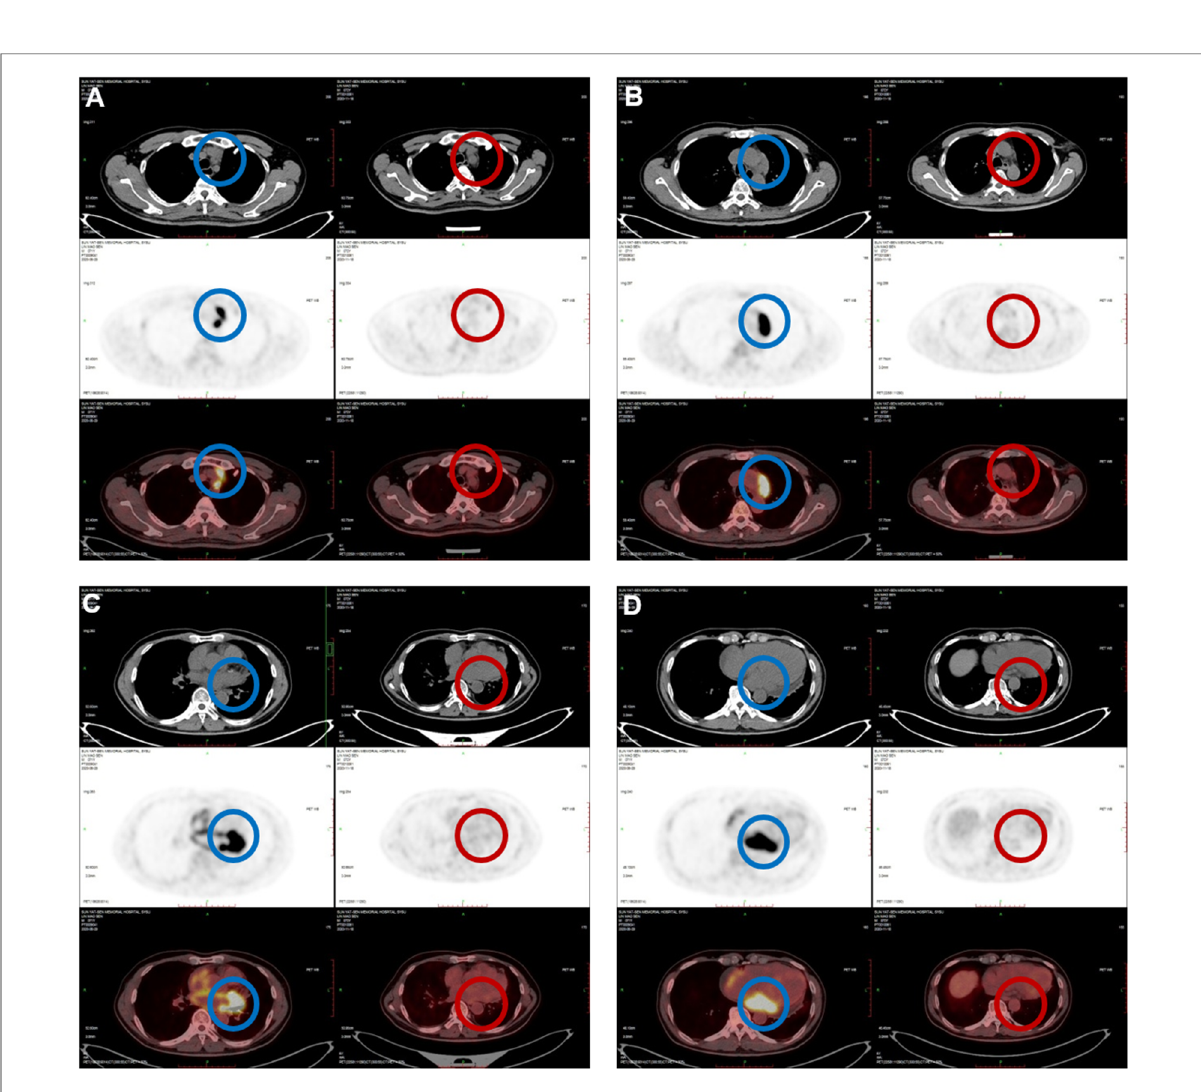
FIGURE 2 PET-CT imaging: ( A ) active FDG uptake of enlarged mediastinal multiple lymph nodes (SUVmax: 27.3) before treatment (in the blue circles); ( B – D ) active FDG uptake of the cardiac mass (SUVmax: 28.7) in the left atrium at the left AV junction (in the blue circles); ( A – D ) after treatment, the previous cardiac mass and enlarged mediastinal lymph nodes had disappeared completely (in the red